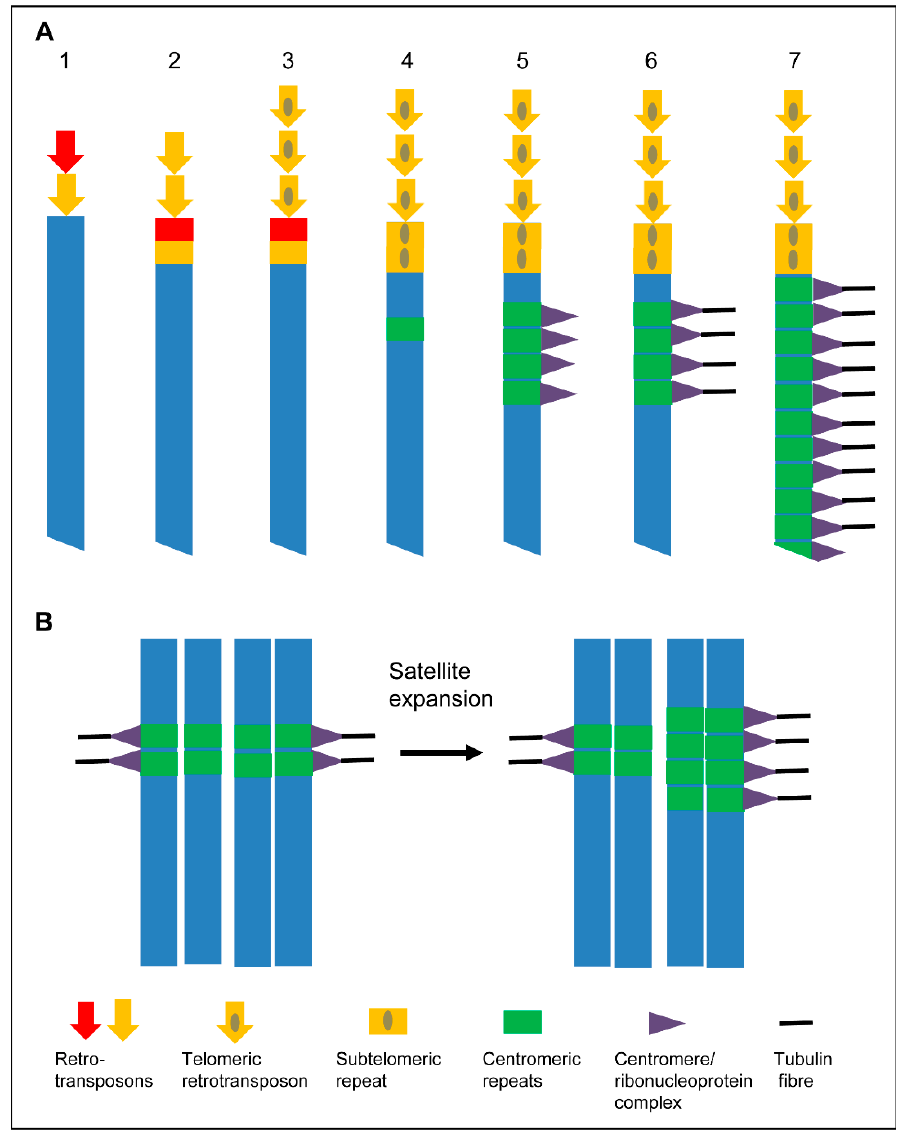
Figure 5. Models to expand centromeres. ( A ) “Telomere to centromere” model based on Villasante et al. [76,77]. (1) Different retroelements are mobilized to heal the DNA ends of a broken chromosome. (2) The most effective telomeric retrotransposons become selected. (3) Retrotransposons with a more effective capping capability are selected. (4) Subtelomeric repeats appear. (5) Subtelomeric repeats are amplified and become centromeric repeats. Ribonucleoprotein complexes are formed after transcription of theses repeats. (6) Centromeric repeats become a protocentromere after being recognized by microtubules. (7) Chromosome wide extension of the centromere to form a holocentromere. ( B ) “Centromere drive model” of Henikoff et al. [2]. The expansion of a satellite that binds CENH3/CENP-A provides more microtubule attachment sites. This stronger centromere drives in female meiosis into the egg cell.